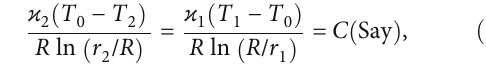
Figure 5: In fl uence of the centrifuge number Ce curves at b ρ = 0 : 002 , b μ ′ = 0 : 5 , b μ = 0 : 03 , L = 0 : 3 , = 9 , and ̂ H = 10 Oh = 100 , Ce 1